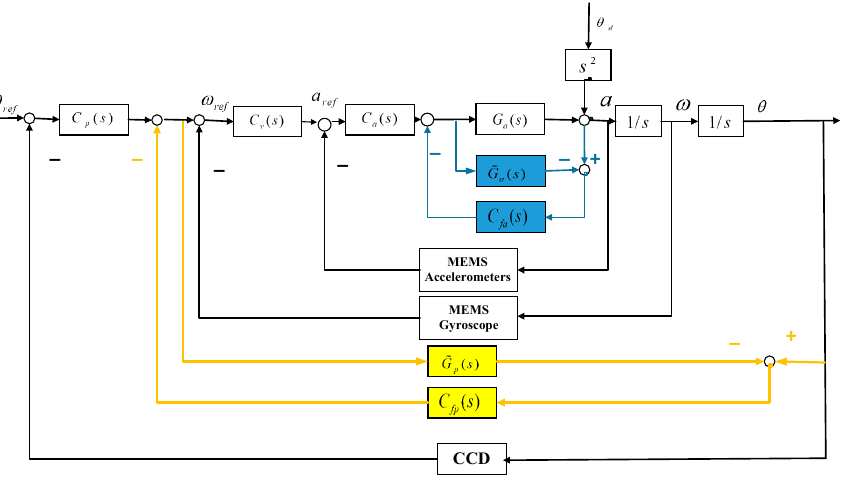
Figure 3. Diagram of the dual disturbance observers structure.